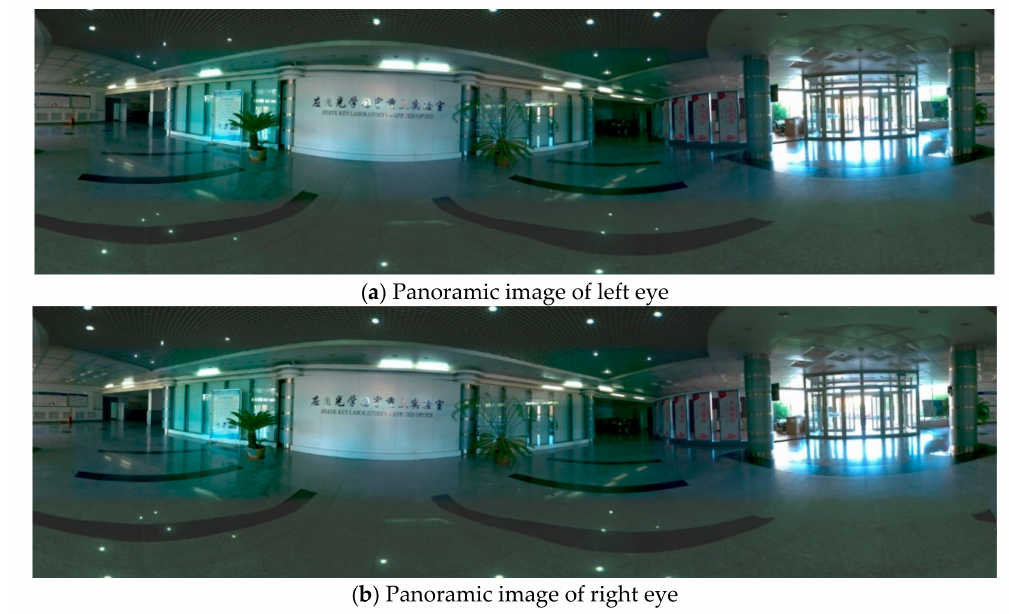
Figure 19. The left ( a ) and right eye ( b ) compose a stereoscopic panorama in uneven